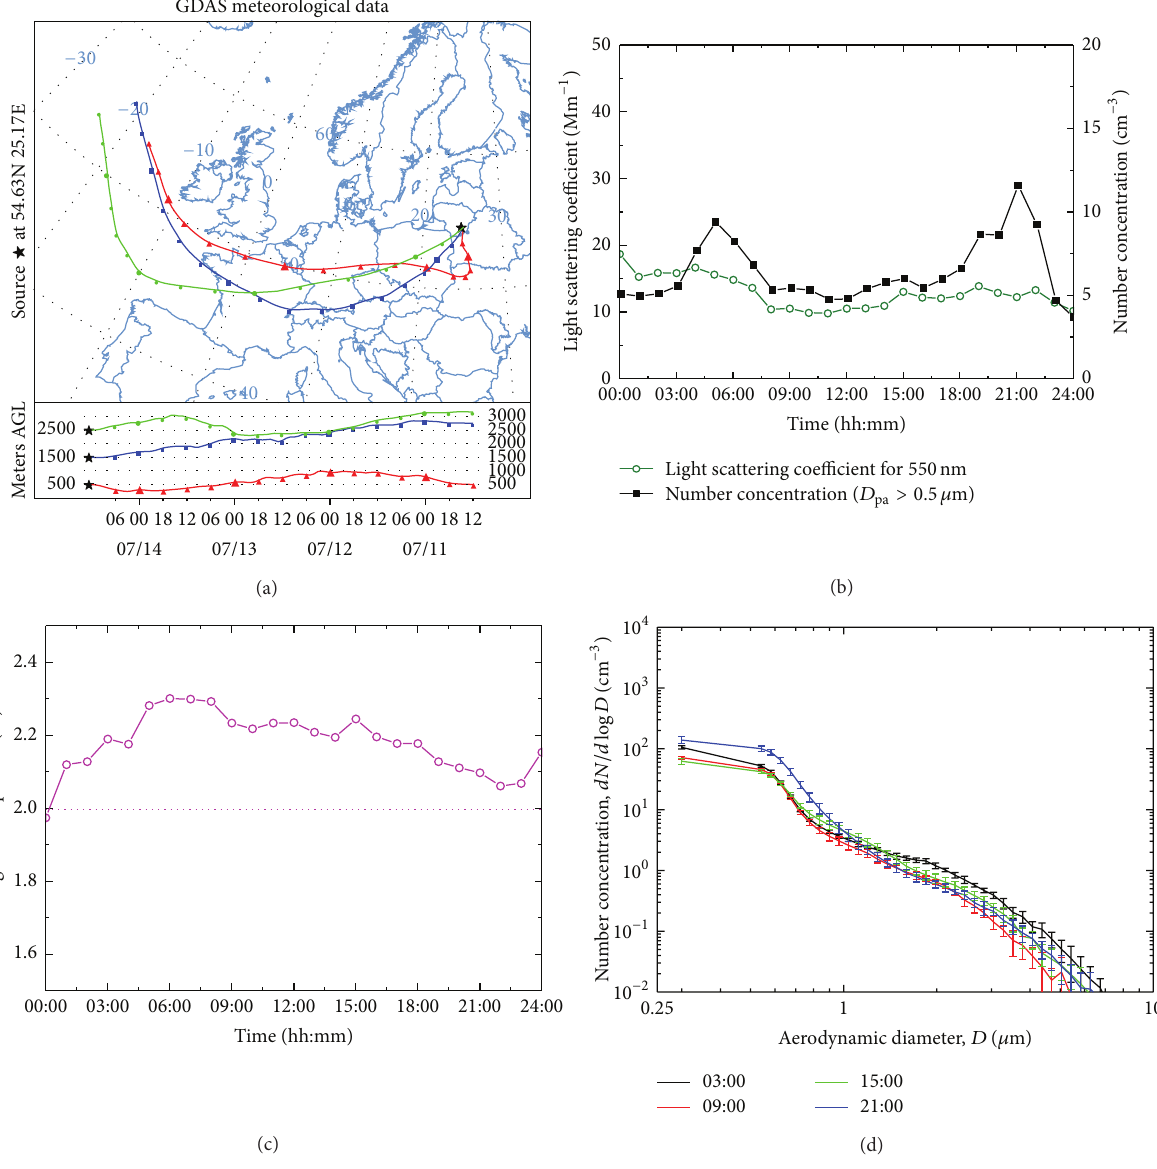
Figure 5: (a) Air parcel trajectory analysis from the National Oceanic and Atmospheric Administration (NOAA) Air Resources Laboratory (ARL) HYSPLIT model. For this analysis, the model was run backwards for 96 hours from 14 July 2012 at 12 UTC. Traces show the origin of air parcels at Vilnius at the 500 m (red), 1500 m (blue), and 2500 m (green) levels. (b) The variation of the measured and hourly averaged values of the light scattering coefficient at 550 nm and the particle number concentration. (c) The calculated ˚Angstr¨om exponent for 450 and 700 nm wavelength pair. (d) The particle size